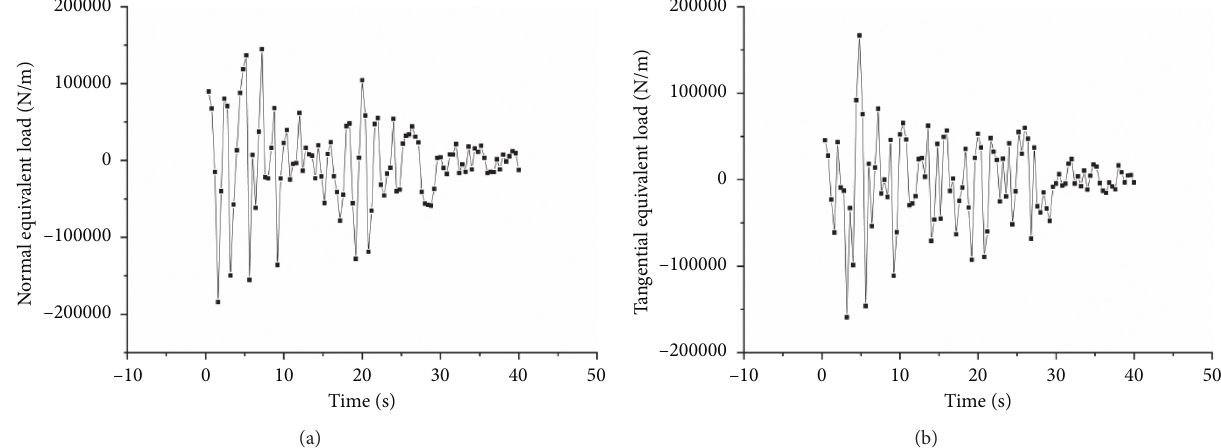
Figure 14: Boundary equivalent loads of the El Centro wave. (a) Normal equivalent load F ( t ) -time curve. F BT